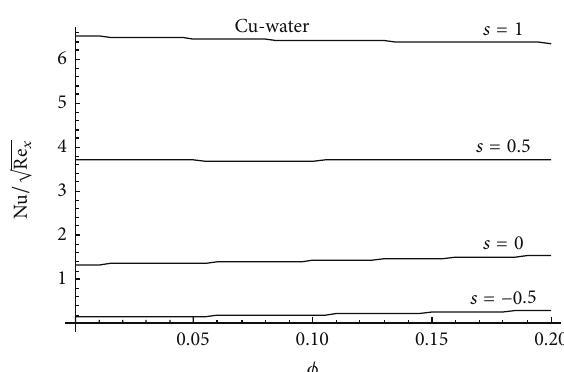
Figure 11: Effect of 𝑠 on reduced Nusselt number as a function of 0 ≤ 𝜙 ≤ 0.2 for Cu nanoparticles when 𝑃𝑟 = 6.2 , 𝛿 1 = 1 , and 𝛿 2 = 0 .